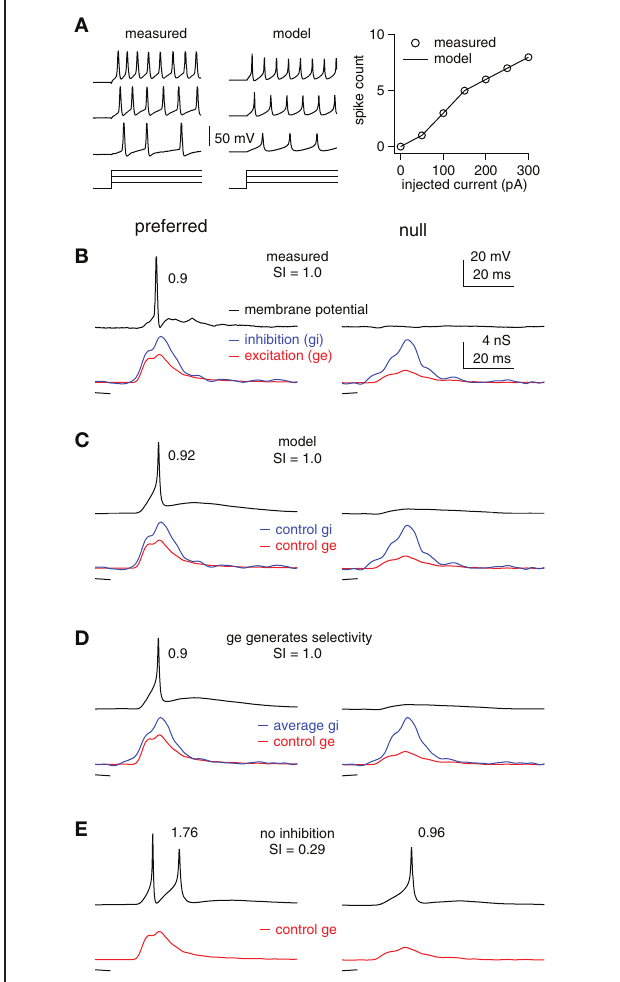
FIGURE 3 | Inhibition enhances FM selectivity by controlling the gain, example cell. (A) Measured and computed responses to 100, 200, and 300 pA current steps (50ms shown). Right: measured and computed I/O functions. (B) Measured membrane potentials (top) in response to preferred (downward, single trace) and null (upward, average of 10 traces) FMs and the derived FM-evoked synaptic conductance (bottom). Spike probability and SI as shown. (C–E) Using the model cell from (A) and the control excitations shown in (B) , we computed membrane responses using (C) the control inhibitions, (D) the average of the preferred and null inhibitions, and (E) no inhibition. Model firing probabilities and SIs as